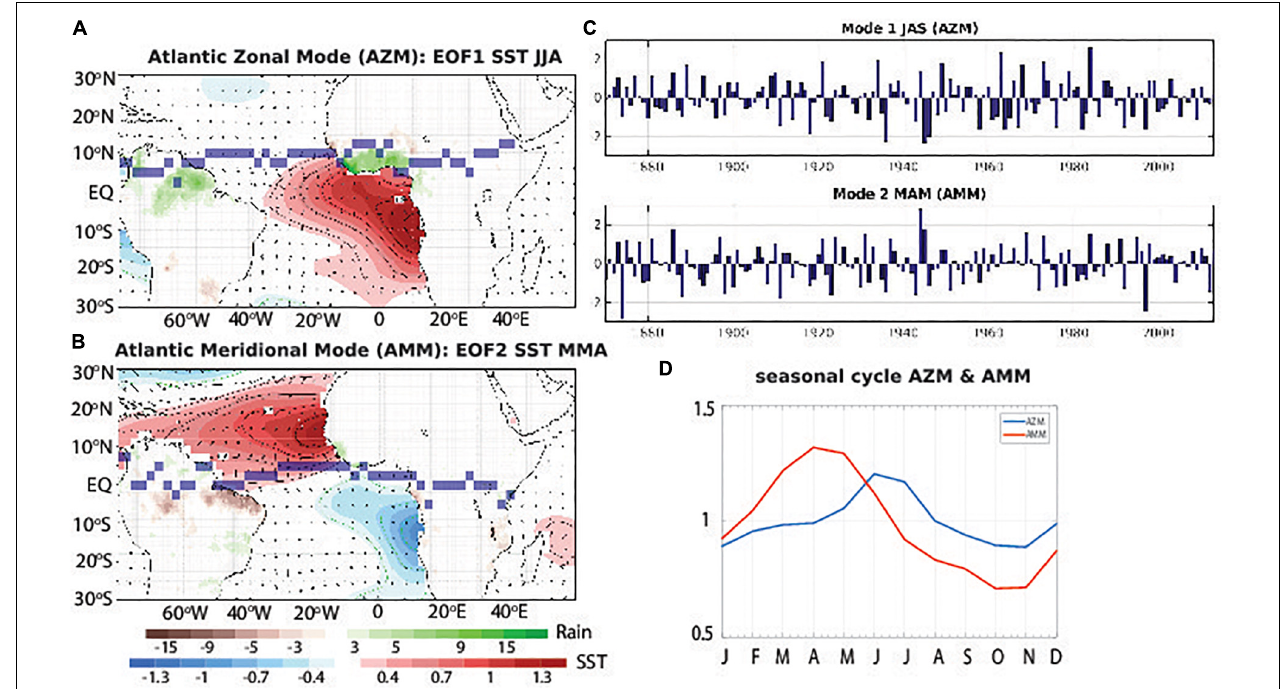
FIGURE 4 | Leading modes of tropical Atlantic SST variability. Shown are the composites of events characterized by a principal component value > 1 standard deviation, minus those events in which the principal component has values < –1 standard deviation. The modes are calculated from Had-SST data ( ◦ C) using an 11-year high pass filter. (A) Composite of the leading mode in June–July–August for SST (shading over ocean), rainfall in cm mo − 1 from University of Delaware (shading over land; data are available from http://climate.geog.udel.edu/ ∼ climate/html_pages/Global2011/README.GlobalTsP2011.html), and surface wind from NCEP 20th Century Reanalysis. (B) As in panel (A) but for the second mode. Purple shading in panels (A) and (B) indicates the seasonal mean position of the ITCZ. (C) Interannual times series of the first and second EOF modes. (D) Evolution of the standard deviation of the leading EOF (blue) and second EOF (red) corresponding to the Atlantic Zonal Mode (AZM) and Atlantic Meridional Mode (AMM),